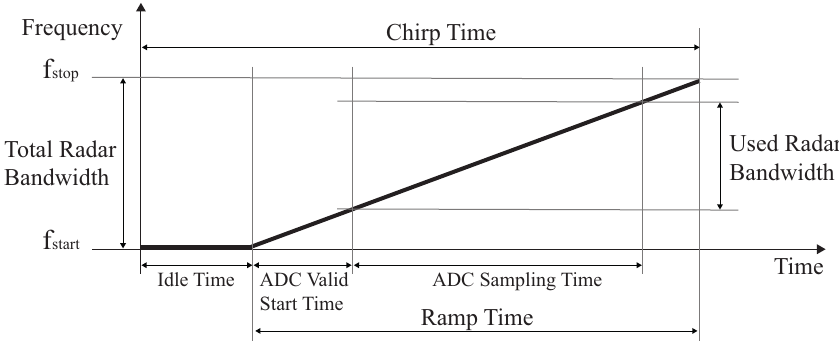
Figure 2. Chirps timing.